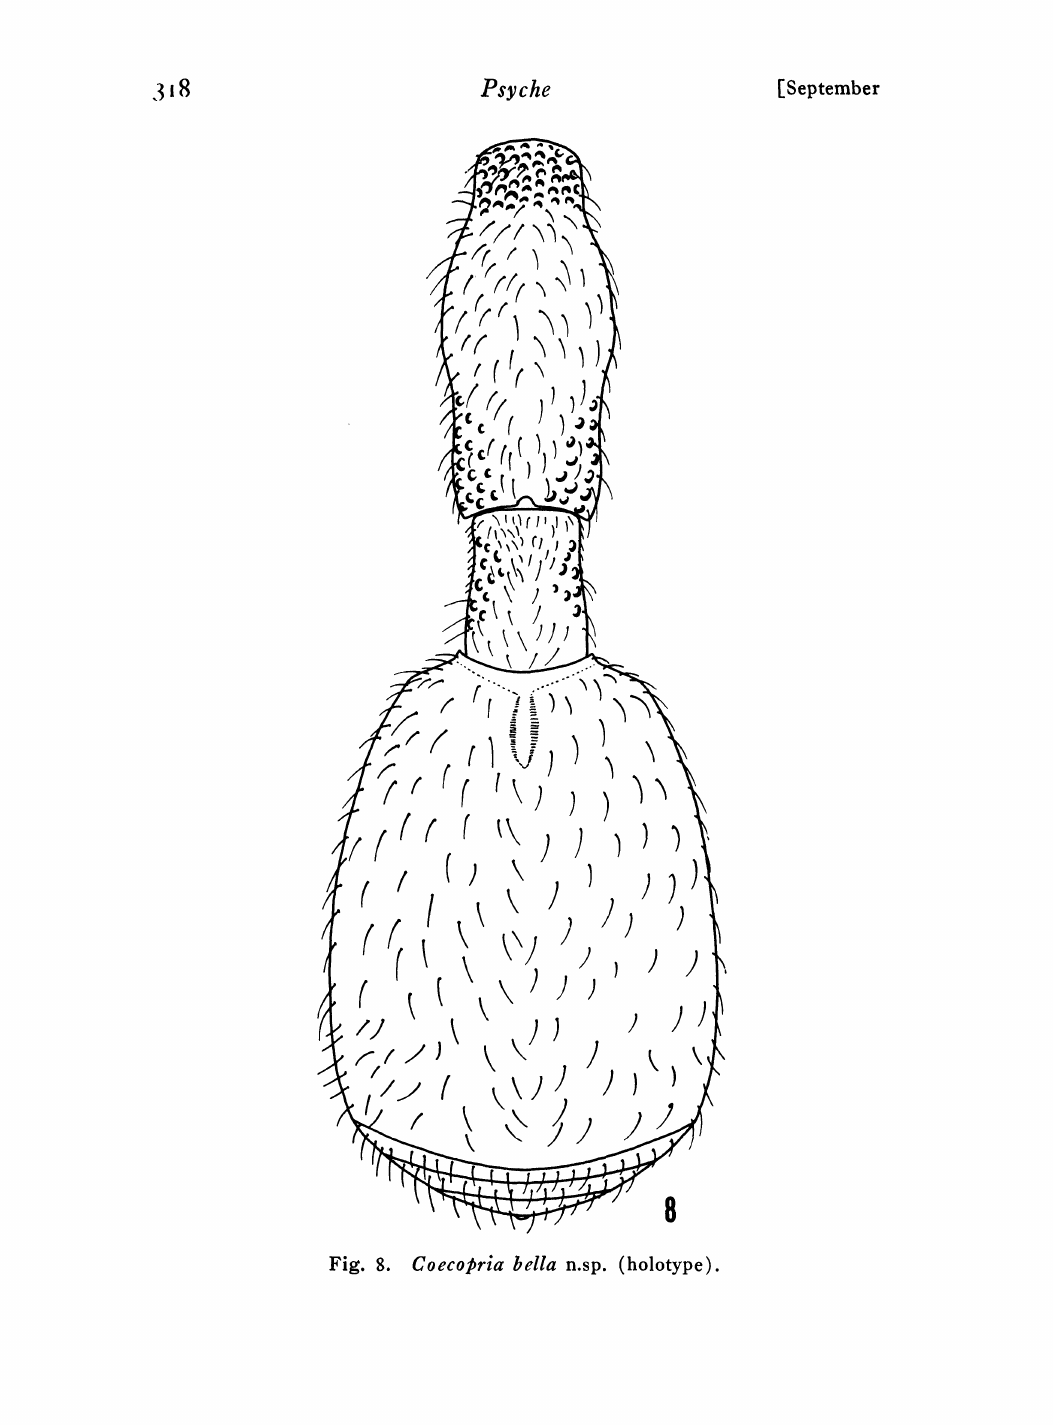
Fig. 8. Coecolria bella n.sp.